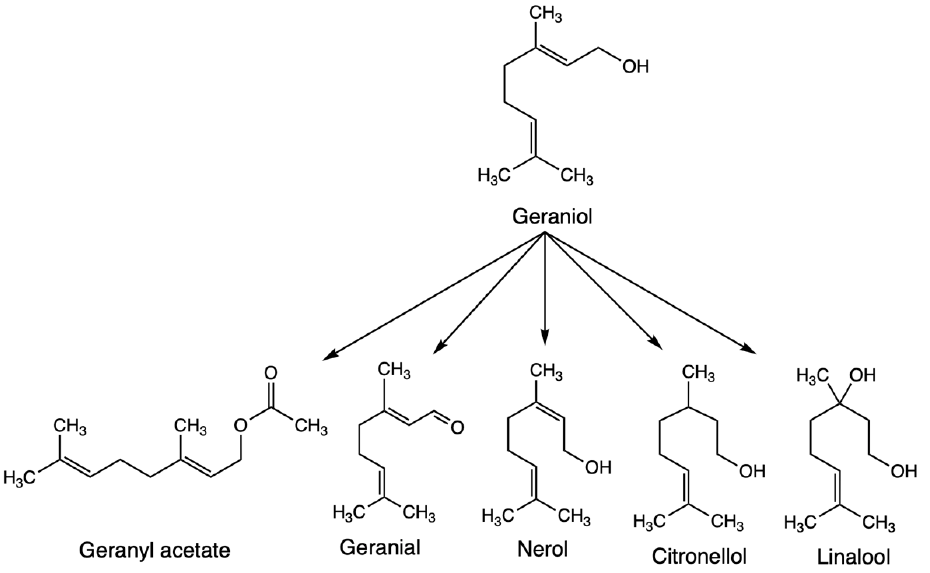
Figure 1. Previously identified biotransformation reactions of geraniol [5,6,20–22]. The current “gold standard” for the identification and off-line monitoring of VOCs is Gas Chromatography/Mass Spectrometry (GC/MS) which is a widely used analytical technique due to its high sensitivity, selectivity, wide linear range, versatility, and precision. GC/MS can detect VOCs at very low concentrations, even in the presence of other compounds. It can separate and identify individual VOCs in a sample, and it can measure a wide range of VOC concentrations, from low parts-per-billion (ppb) to high parts-per-million (ppm) levels [23]. However, drawbacks of GC/MS include the long time required for a single analysis due to its labour-intensive sample preparation and quantitative analysis requiring reference standards [24]. In contrast, PTR-ToF-MS suits rapid quantitative analysis of VOCs in complex mixtures. It is an ultra-high sensitive technique that allows for the online analysis of VOCs based on their mass-to-charge ratio and can detect trace gases at ultra-low concentration levels (low ppt). A limitation of PTR- ToF-MS is that isomers are not distinguishable. Therefore, identification should be complemented by another analytical technique, such as GC/MS [25–27] or by implementing additional tools, such as fast-GC [28]. These two techniques have been previously used to measure VOCs in cheese, potatoes, infant formula, blueberries, milk, olive oil and truffles [26,29–31] and can support the identification of spectrometric peaks used for rapid monitoring over time [26,32]. The rapid PTR-MS-based methods also allow for the measurement of a larger number of replicates, making results statistically more robust. Therefore, two separate analyses were carried out at the same time in this study: one using SPME-GC/MS of a few select time points to identify the VOCs present, and the other using PTR-ToF-MS at more time points to monitor the generation of the VOC overtime more accurately. The overall aim of the current study was to monitor the dynamic changes of geraniol during beer fermentation to understand and quantify in real time the point at which differences between S. cerevisiae and S. pastorianus yeast occurred and to provide new information on the biotransformation of geraniol during beer production.